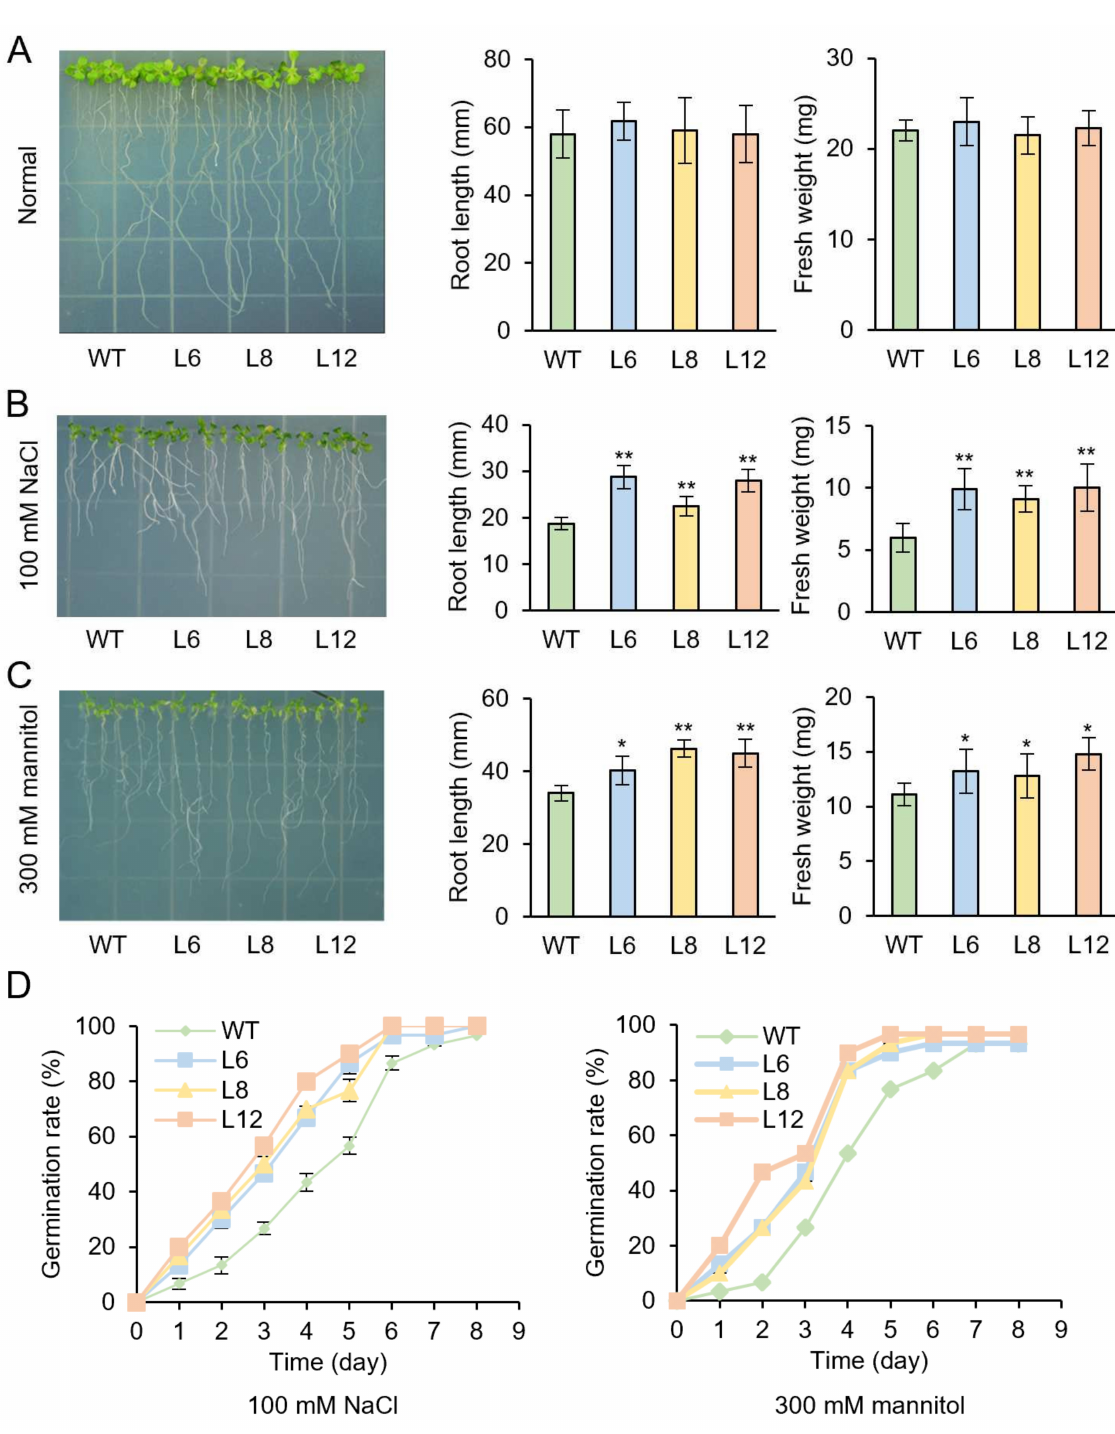
Figure 6. Response of transgenic and WT seedlings under salt and drought stresses. ( A – C ) Root length and fresh weight of WT and transgenic lines cultivated separately on 1/2 MS medium with normal ( A ), 100 mM NaCl ( B ) or 300 mM mannitol ( C ) for 7 days. ( D ) The germination rate of transgenic and WT seeds, which were cultured on 1/2 MS medium with 100 mM NaCl or 300 mM mannitol, respectively. Asterisk (*) and (**) indicate a significant difference from the WT at values of p < 0.05 and p < 0.01, individually, by Student’s t